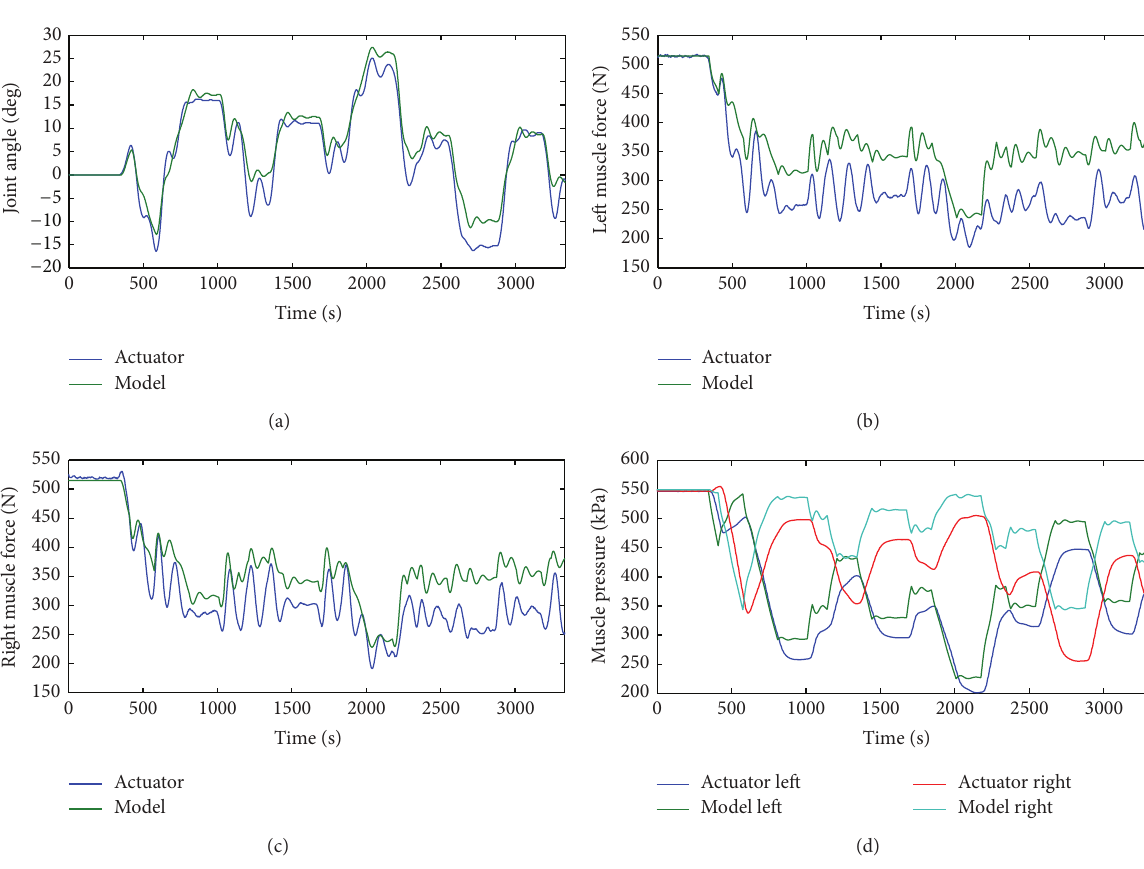
Figure 10: Comparison of model and actuator performance for the excitation signal shown in Figure 8 with 11-multiple of moment of inertia ((a) joint angle response, (b) left muscle force response, (c) right muscle force response, and (d) muscle pressure response in both muscles).